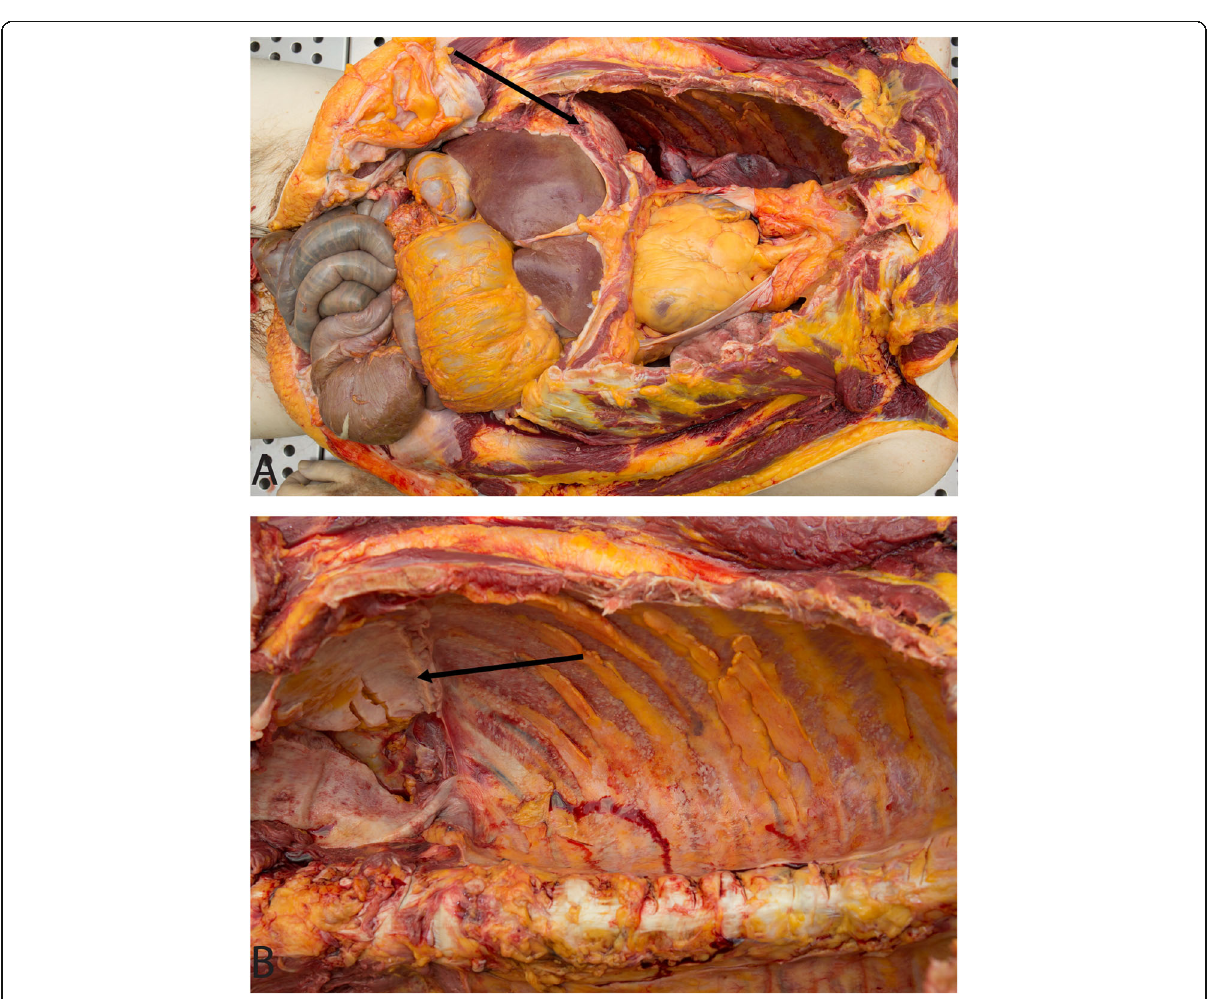
Fig. 1 Plasmacytoid Urothelial Carcinoma in the Abdomen (in Situ). The diaphragm was diffusely thickened in a white plaque of tumor ( a , shown before evisceration by arrow) and the peritoneal/serosal surface was diffusely thickened in a white plaque of tumor ( b , shown after evisceration by